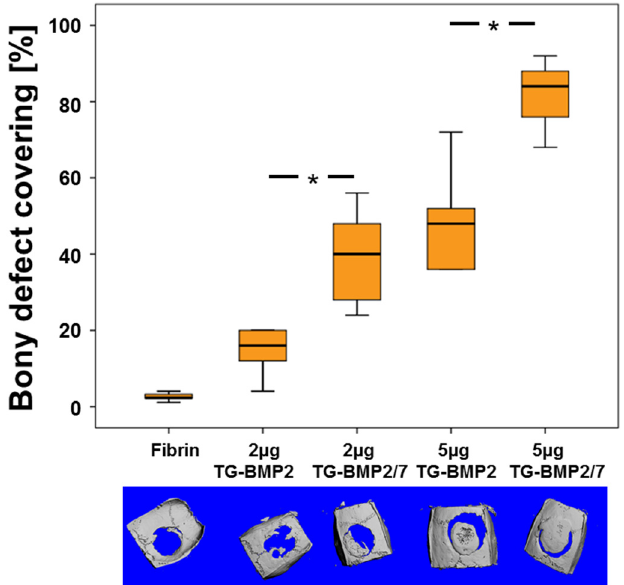
Figure 7. Bony covering of critical size calvarial defects in the rat. The ability of TG-BMP2 and TG-BMP-2/BMP-7 in fibrin matrices to promote healing was examined in 8 mm defects in the rat, one per animal (n ≥ 5 for each group). The area of the defect covered with calcified tissue after 35 days of healing with standard errors is shown along with µCT top views (lower panel). * indicates significance with a p <